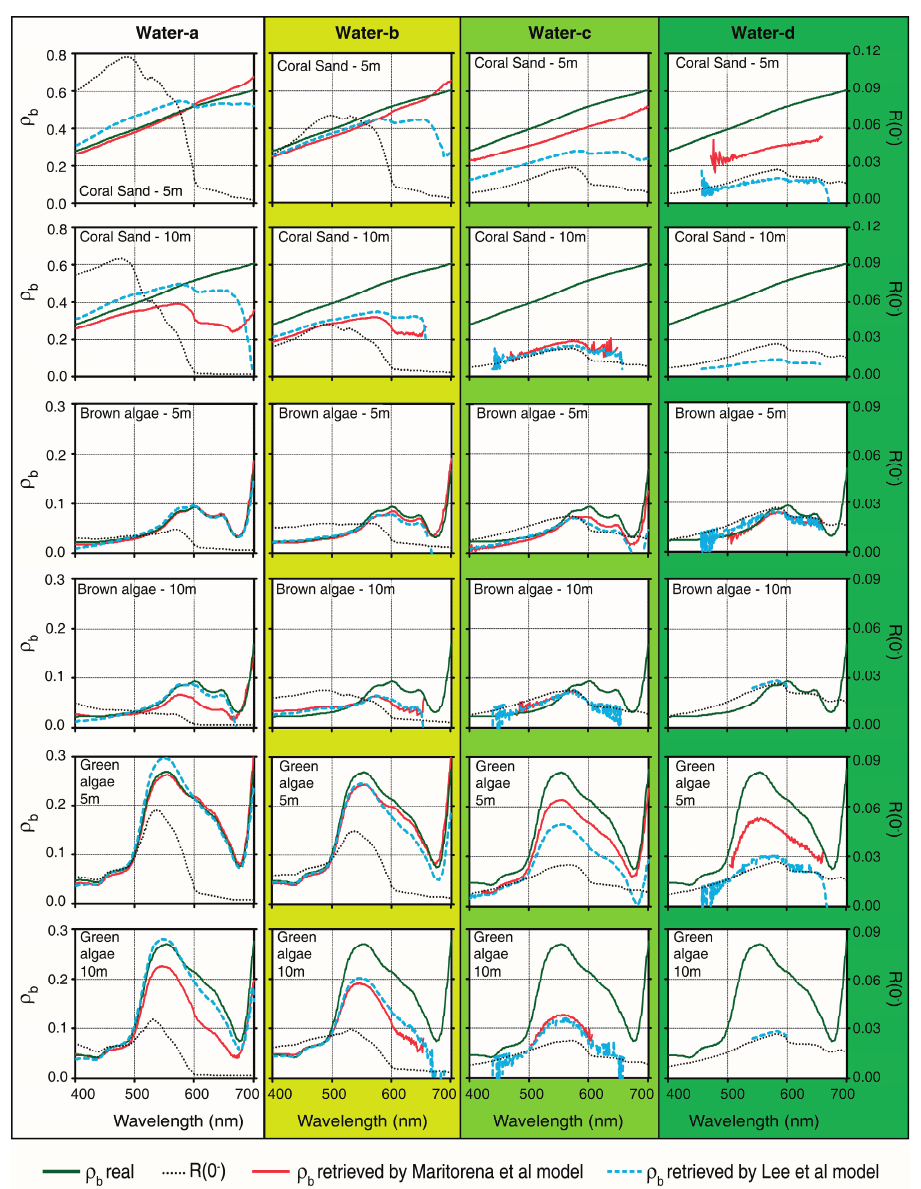
Figure 6. Bottom reflectance below water versus wavelength (nm) retrieved using L99 (in blue ) and M94 (in red ), compared with real bottom reflectance. In lines, there are results for the same type of substrate and depth. In columns, there are results for the same kind of